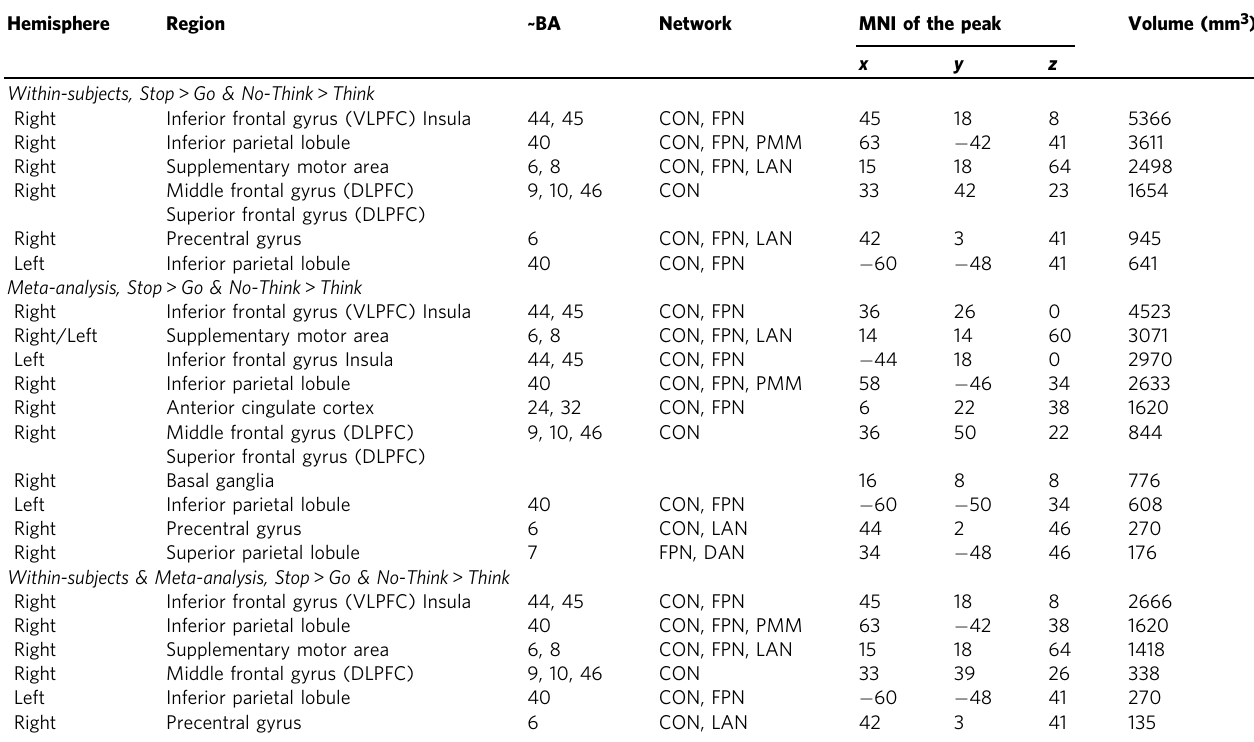
Table 1 Within-subjects and meta-analysis domain-general inhibition-induced activations (Stop > Go and No-Think > Think). Hemisphere Within-subjects, Stop > Go & No-Think >